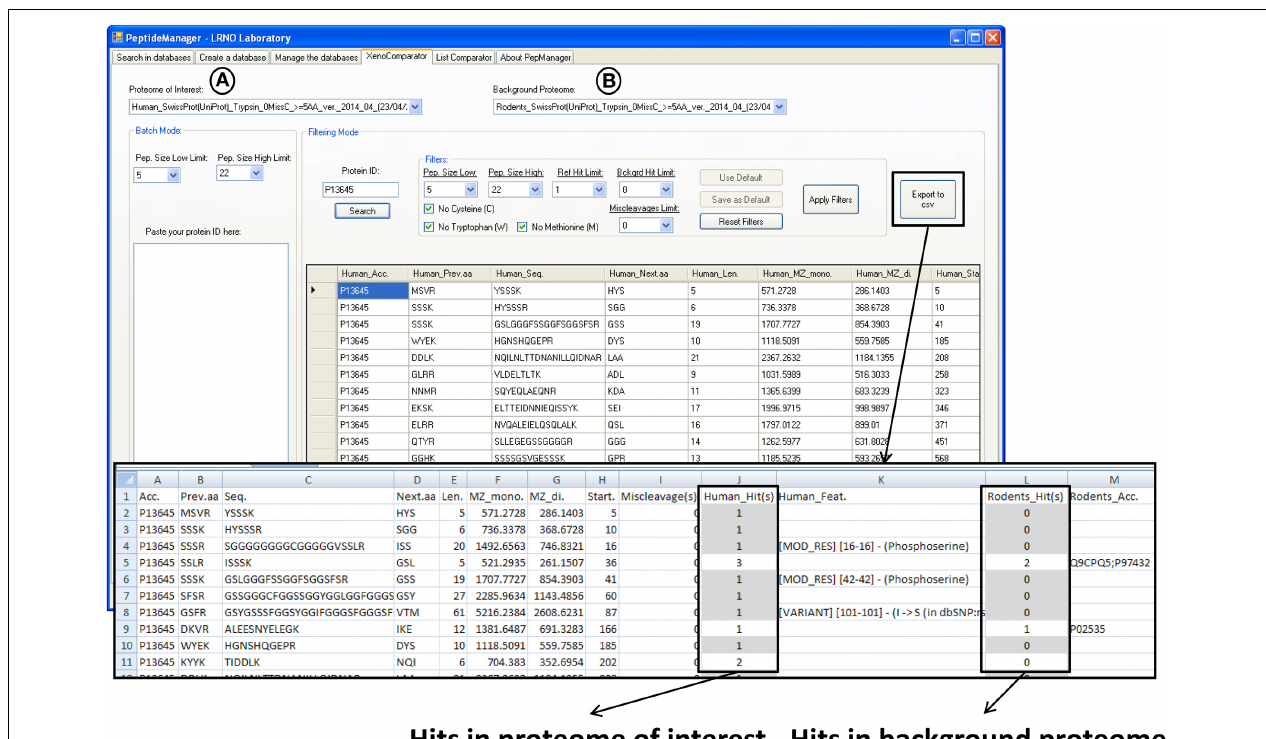
FIGURE 4 | Print screen showing the results obtained with PeptideManager for the human P13645 protein within the mouse proteome (host proteome). The information concerning both proteomes [selected proteomes in (A,B)] is brought together and the number of